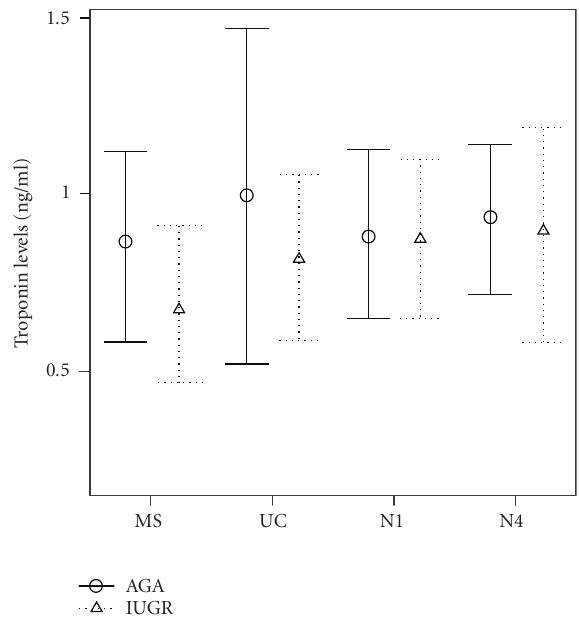
Figure 1: Cardiac troponin-I (cTnI) levels in maternal (MS), fe- tal (UC), neonatal day 1 (N1), and neonatal day 4 (N4) serum of intrauterine growth-restricted (IUGR) and appropriate-for- gestational age (AGA) groups. Error bars represent mean and 95% confidence interval of the